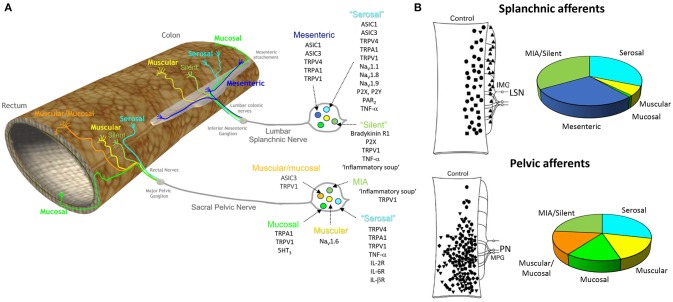
Different classes of afferent innervating the colon and rectum and the ion channels and receptors contributing to their function. (A) The colon and rectum are innervated by two distinct spinal pathways, the lumbar splanchnic and sacral pelvic nerves. The cell bodies of these splanchnic and pelvic afferents are located within the thoracolumbar (T10-L1) and lumbosacral (L6-S1) DRG, respectively. Six broad classes of afferents exist. (1) mesenteric (splanchnic only), (2) muscular/mucosal (pelvic only), (3) serosal (splanchnic and pelvic pathway), (4) muscular (splanchnic and pelvic pathway), (5) mucosal (splanchnic and pelvic pathway) (Brierley et al., 2004), and (6) mechanically insensitive ‘silent’ afferents (splanchnic and pelvic pathway), which lack mechanosensitivity in naïve conditions but are recruited by chemical stimuli (Brierley et al., 2005a; Feng and Gebhart, 2011). A key list of excitatory ion channels and receptors that contribute to afferent function are listed for each subclass (Brierley, 2010). (B) Distribution of the receptive fields of afferent endings throughout the distal colon and rectum from Hughes et al. (2009b) with permission, with the percentages of the respective afferent classes recorded within the splanchnic and pelvic nerves (Brierley et al., 2004; Hughes et al., 2009b; Feng and Gebhart, 2011). ASIC, Acid sensing ion channel; TRP, transient receptor potential channel (TRP); vanilloid 1 (TRPV1), vanilloid 4 (TRPV4), ankyrin 1 (TRPA1), voltage-gated sodium channel: Nav, MIA, mechanically insensitive afferents; TNF-a, tumor necrosis α, interleukin receptor (IL-R); P2X, ligand-gated ion channel; P2Y, G-protein-coupled purinoceptor; 5-HT3, 5-Hydroxytryptamine receptor 3; PAR2, protease activated receptor 2. Bradykinin R1, Bradykinin receptor 1.